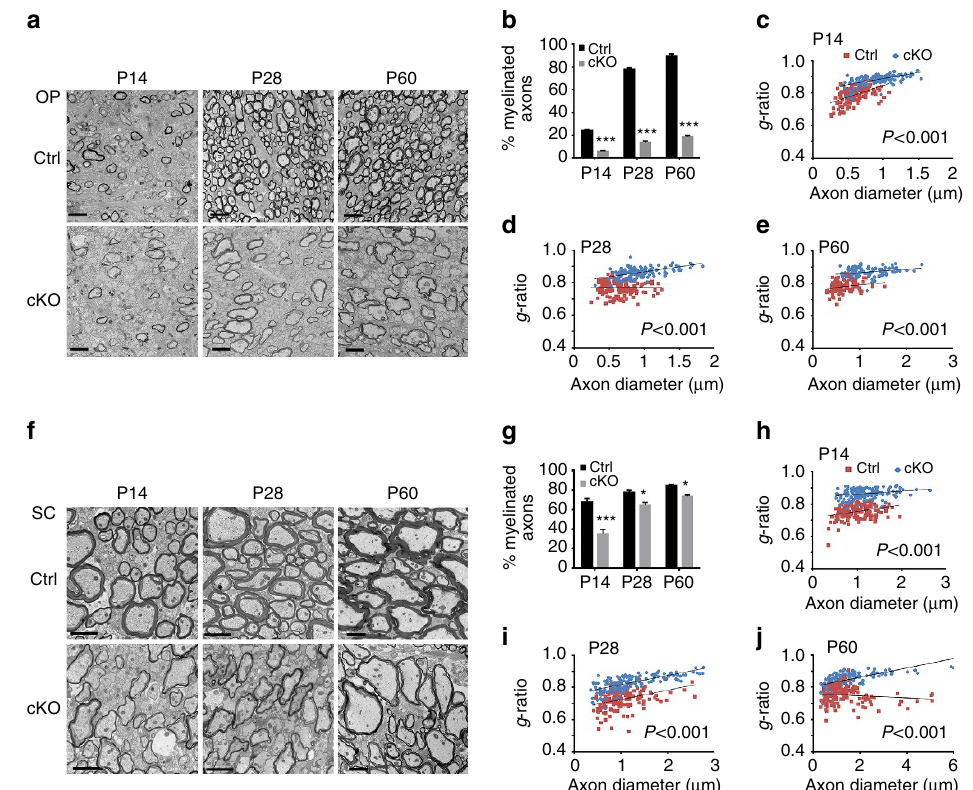
Figure 2 | Tsc1 cKO mice develop myelinogenesis defects. ( a ) Representative electron micrographs of optic nerves in control and Tsc1 cKO mutants at P14, P28 and P60. Scale bar, 2 m m. ( b ) The percentages of myelinated axons in the optic nerves of control and Tsc1 cKO mice at indicated stages. Data represent the mean ± s.e.m. from three animals; *** P o 0.001; Student’s t -test. ( c – e ) g -ratio plotted versus axon diameters in the optic nerves of control and Tsc1cKO mice at P14 ( c ), P28 ( d ) and P60 ( e ). The data were displayed using scatter plots. n ¼ 3 animals for each genotype ( Z 150 myelinating axons were counted for each genotype). Student’s t -test. ( f ) Representative electron micrographs of the spinal white matter in controls and Tsc1cKO mutants at indicated stages. Scale bar, 2 m m. ( g ) The percentages of myelinated axons in the spinal cord white matter of control and Tsc1 cKO mice at indicated stages. Data represent the mean ± s.e.m. from three animals; * P o 0.05; *** P o 0.001; Student’s t -test. ( h – j ) g -ratio plotted versus axon diameters in the spinal white matter of control and Tsc1cKO mice at P14 ( h ), P28 ( i ) and P60 ( j ). The data were displayed using scatter plots . n ¼ 3 animals for each genotype ( Z 150 myelinating axons were counted for each genotype). Student’s t